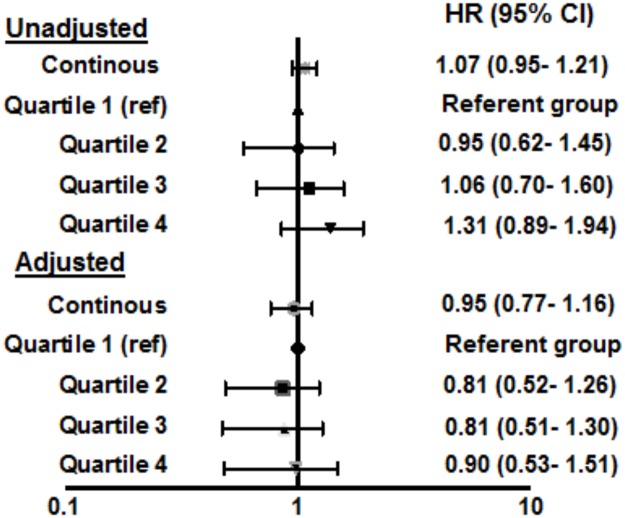
Forrest plot of the risk for incident cancer per 1-unit standard deviation increase in log-transformed leptin levels, and by quartiles, before and after adjustment for clinical and demographic variables.Model is adjusted for sex, race, age, smoking status, alcohol use, family history of cancer, body mass index, diabetes mellitus and C-reactive protein. Data is given as hazard ratio (95% confidence intervals).